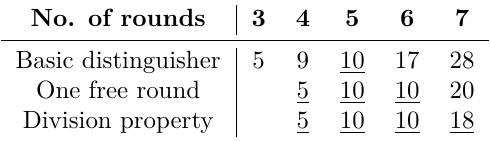
Table 5: Number of bits required to vary in the zero-sum distinguishers using the same computations as in [DEM15]. “One free round” refers to the technique from Boura et al. [BC10a] and used in [DEM15] to add one round in the middle of the basic distinguisher. “Division property” was calculated based on the Algorithm 2 from